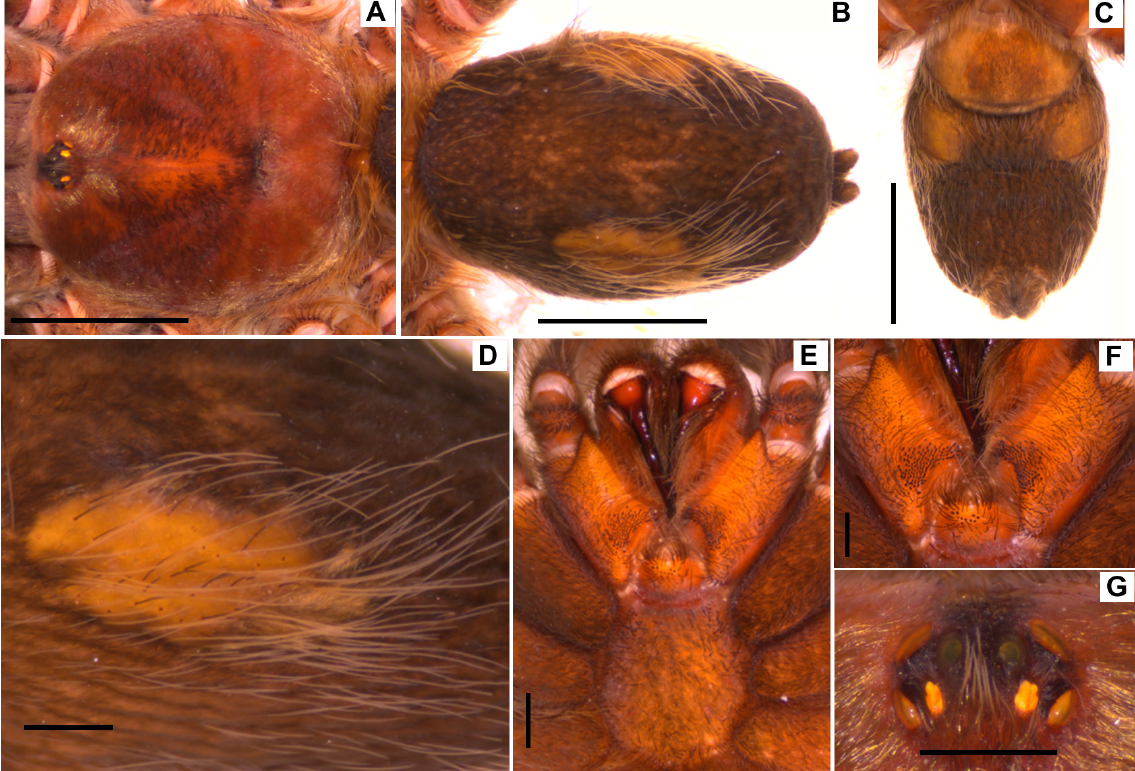
Fig. 8. Bistriopelma kiwicha sp. nov., holotype, ♂ (MUBI 12). A . Carapace, dorsal view. B . Abdomen, dorsal view. C . Abdomen, ventral view. D . Urticating setae patch. E . Sternum, labium and maxillae, ventral view. F . Labium and maxillae, ventral view. G . Eyes. Scale bars: A–C = 5 mm; D–G = 1